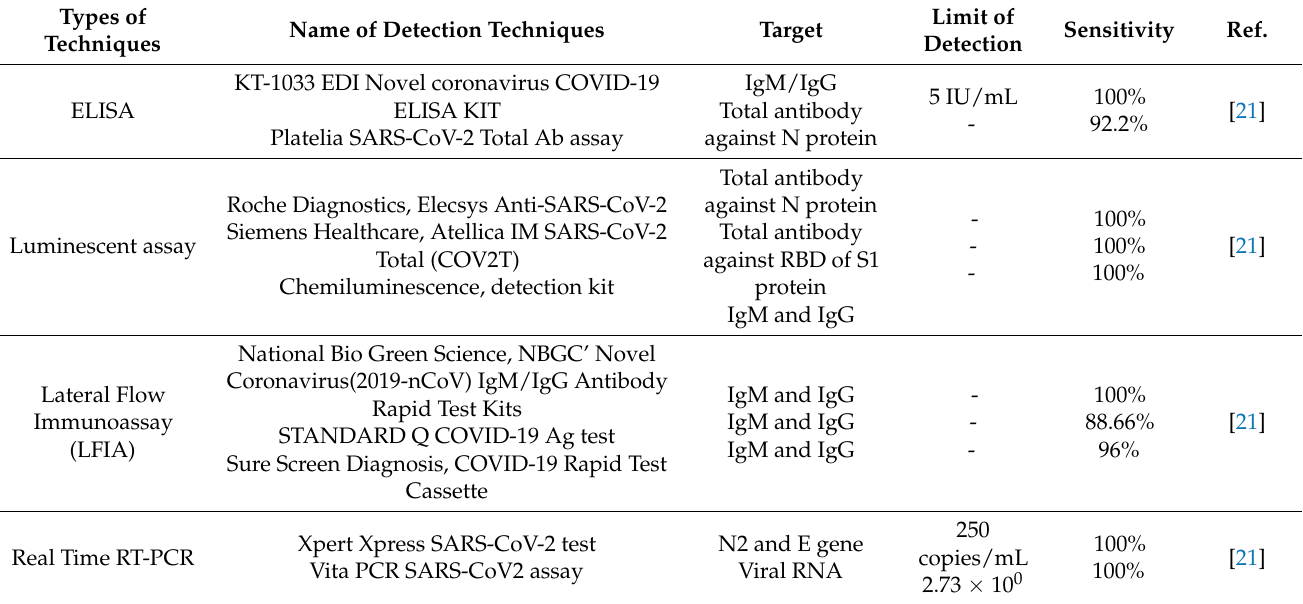
Table 1. Traditional methods for COVID-19 detection.